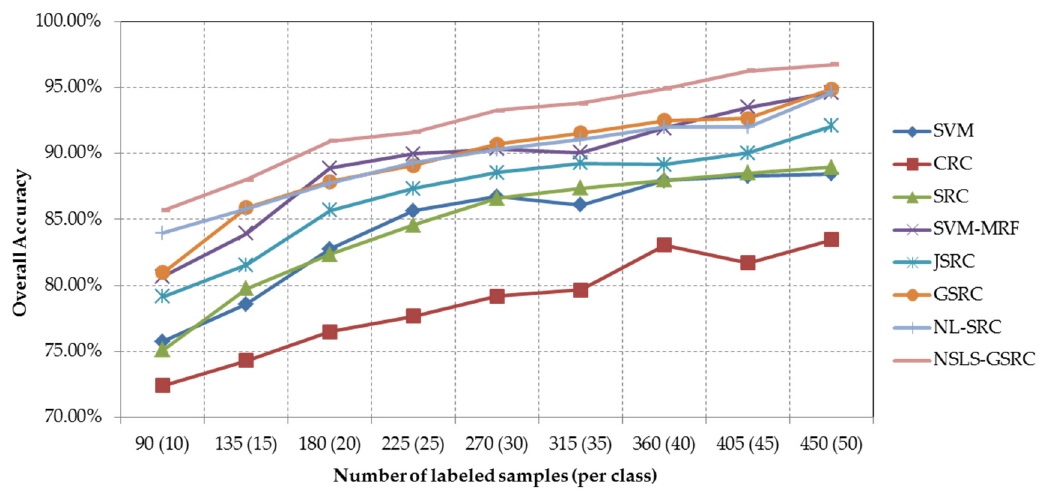
Figure 11. Overall classification accuracy obtained by the different tested methods versus different number of labeled samples for the ROSIS University of Pavia scene. Table 6. Overall accuracies (in percent) obtained by the different tested methods using different number of labeled samples (per class) for the University of Pavia scene. The best results are in bold.